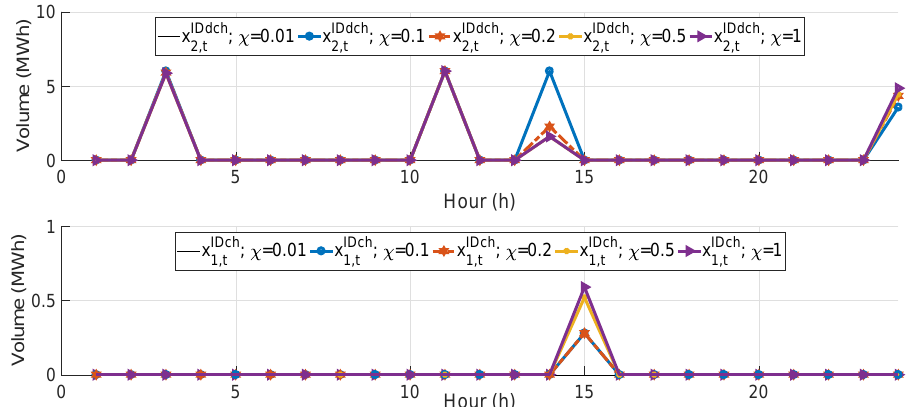
Figure 10. Intra-day trading strategies; T-CVaR risk aversion shift in intra-day bids of 24 h of planning day (upper figure-discharging bids, lower figure-charging bids).